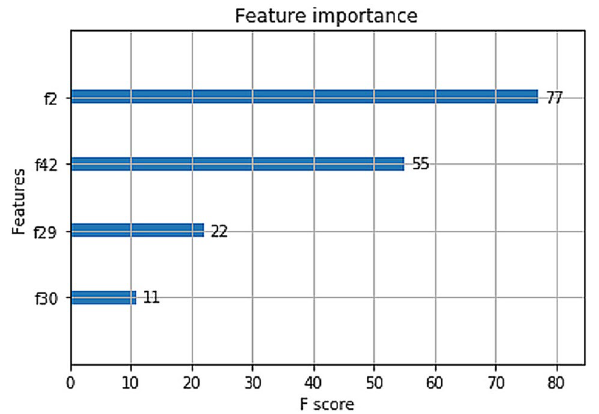
Figure 3. Features importance in classifier based on XGBoost. f2: BMI; f42: TG; f29: ALT; f30: ratio of AST/ ALT. BMI body mass index; TG triglyceride; ALT alanine aminotransferase; AST aspartate